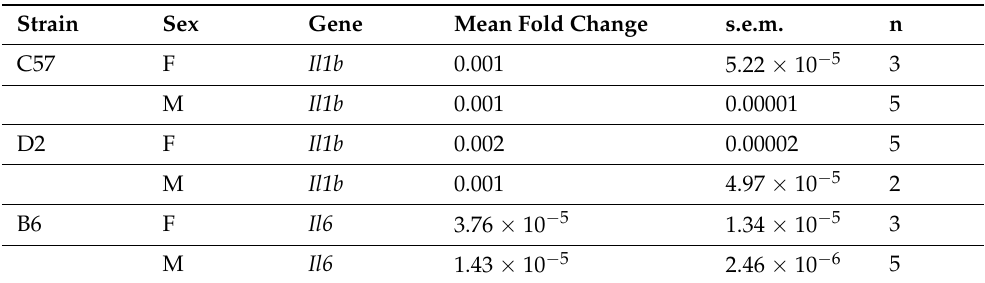
Table 1. Proinflammatory cytokine gene expression in animals exposed to air, i.e., the controls for Figure